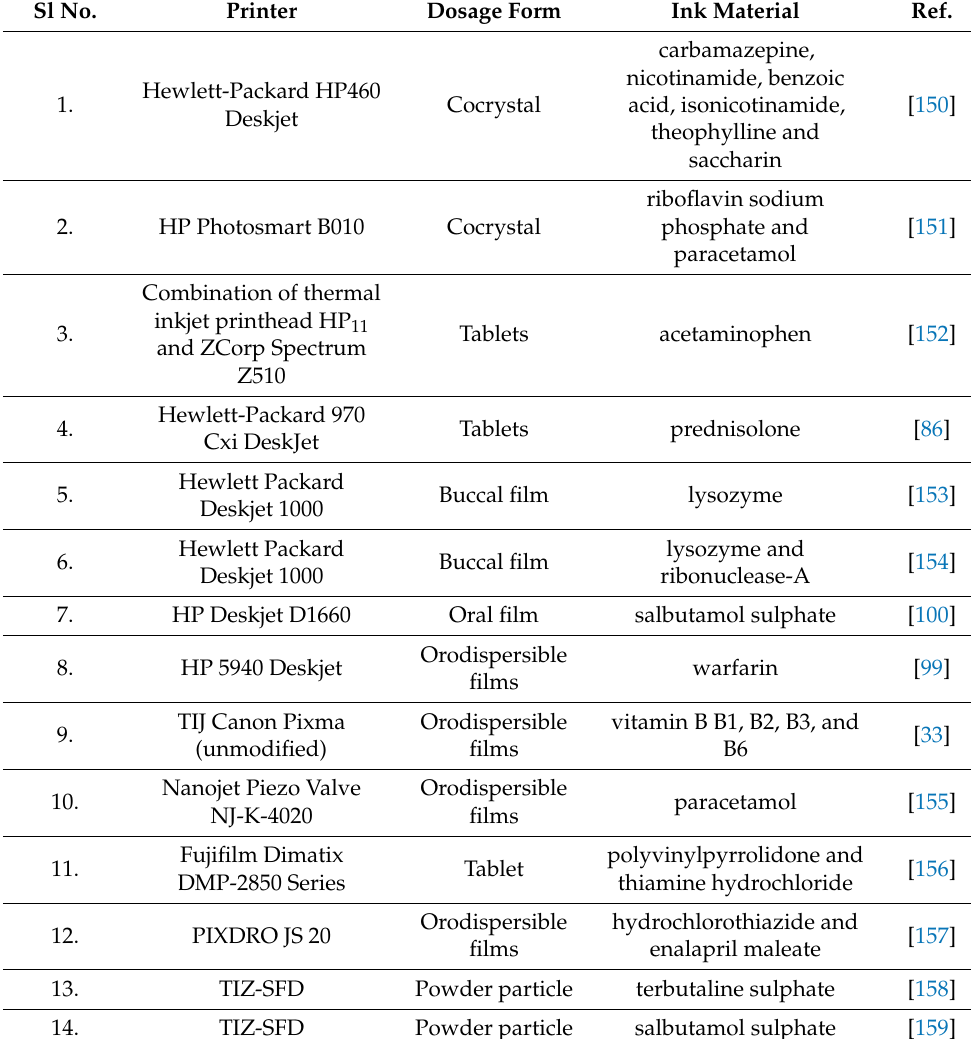
Table 4. TIJ printing examples used in printing of oral solid dosage